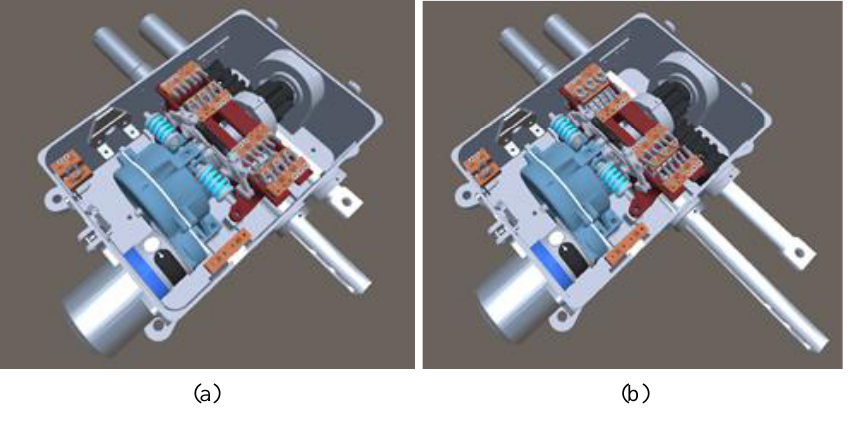
Figure 5. The behavior simulation of the switch machine: ( a ) in normal directions; ( b ) in reverse